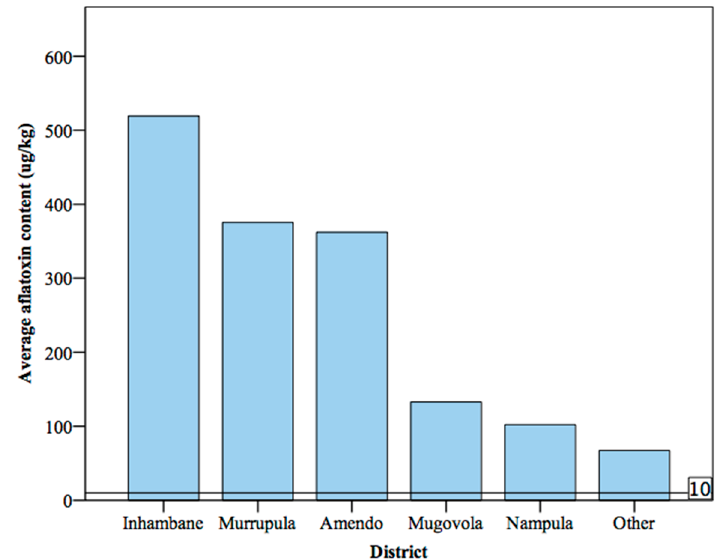
Figure 6. The districts with the highest aflatoxin levels in their foods. The horizontal line crossing the bars and the number at the right corner represent the maximum limit for peanuts (10 µg/kg) recommended by the Codex Alimentarius Commission [9]. Based on Casadei [6], Van Rensburg et al. [7], van Wyk et al. [1], Warth et al. [2] and Sineque et al. [8]. These studies were carried from 1985 to 2017 and included in total 934 samples including agricultural crops, chicken livers and gizzards.